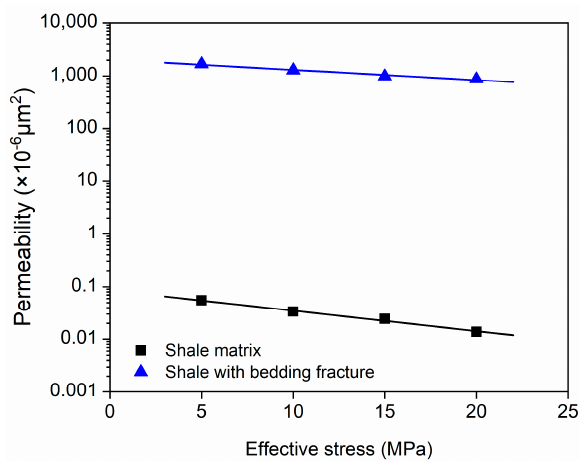
Figure 9. Variation of permeability with effective stress for Wufeng–Longmaxi shales at the Anchang syncline.